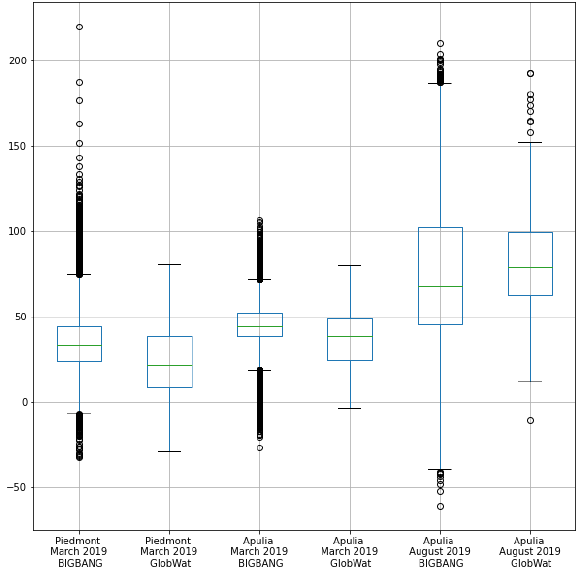
Figure 9. Boxplot of the ET values resulting from BIGBANG and GlobWat models for the area of interest in the different